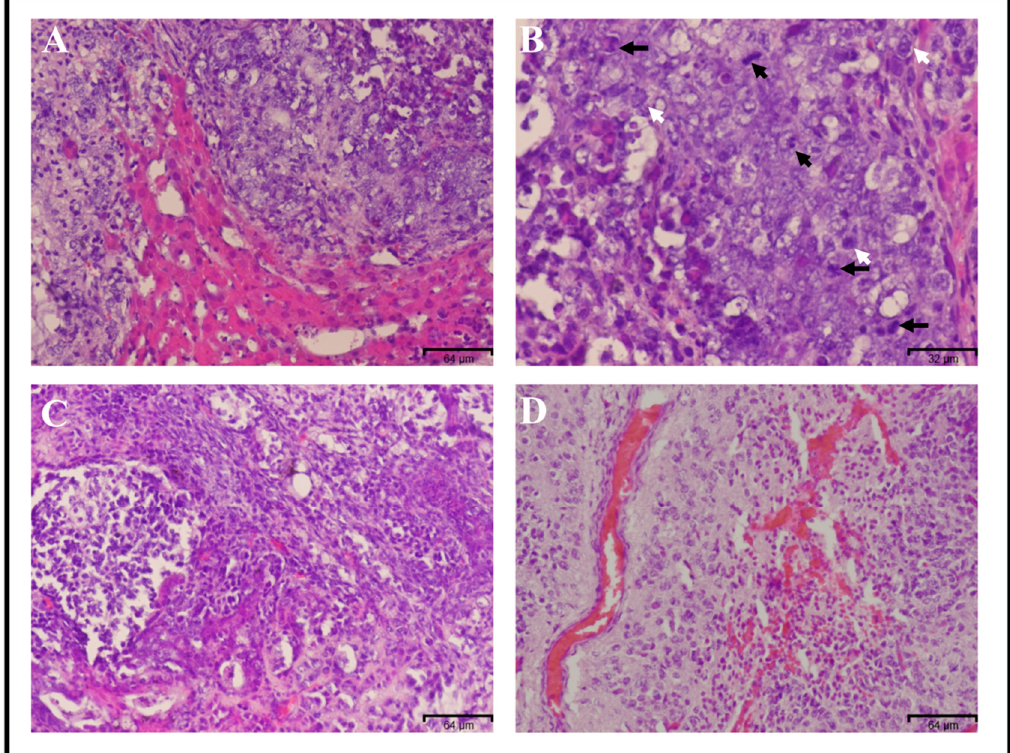
Figure 4. Histological analysis of the tumor derived from transplantation of miPS-PLCcm cells. Hematoxylin and eosin staining showed tumor invasion inside the normal liver ( A ). Original magnification 20 × . This tumor tissue showed malignant phenotype criteria such as mitotic figures (black arrows), nuclear atypia (white arrows) ( B ) Original magnification 40 × , high nuclear to cytoplasmic ratio ( C ) and angiogenesis ( D ). Original magnification 20×. The malignant tumor derived from miPS-PLCcm cells was assessed for several markers by